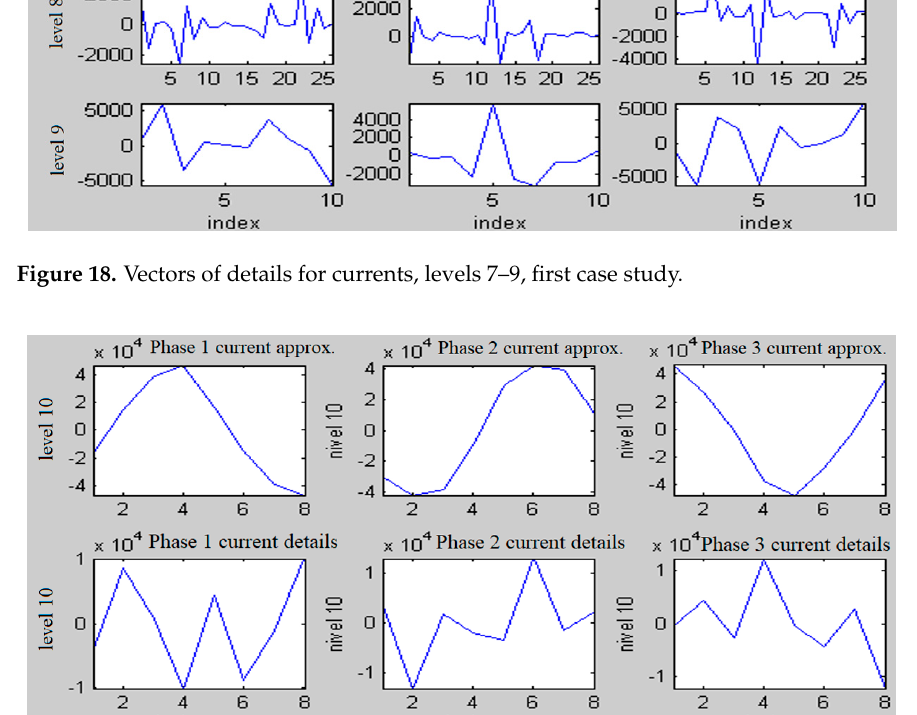
Figure 19. Vectors of approximations and details for current, level 10, first case study.